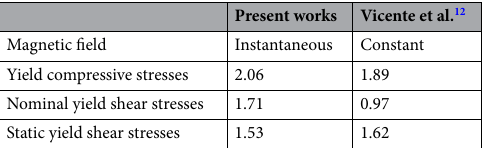
Table 1. Comparison between the present with the previous works about power law exponent n for the yield stress according to τ d = αB n .